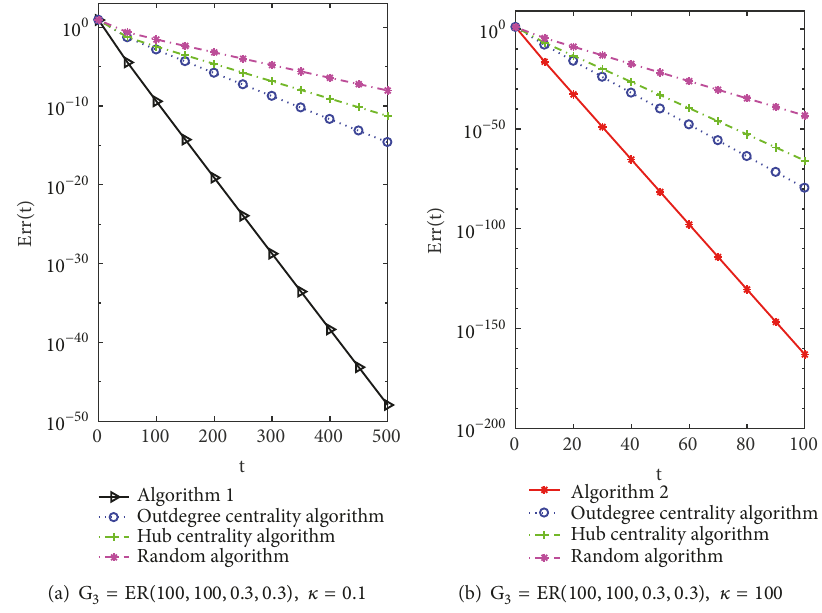
Figure 3: Dynamics of Err (𝑡) with different pinning algorithms. The pinned node number is fixed to be 5. Averaged over 20 times.